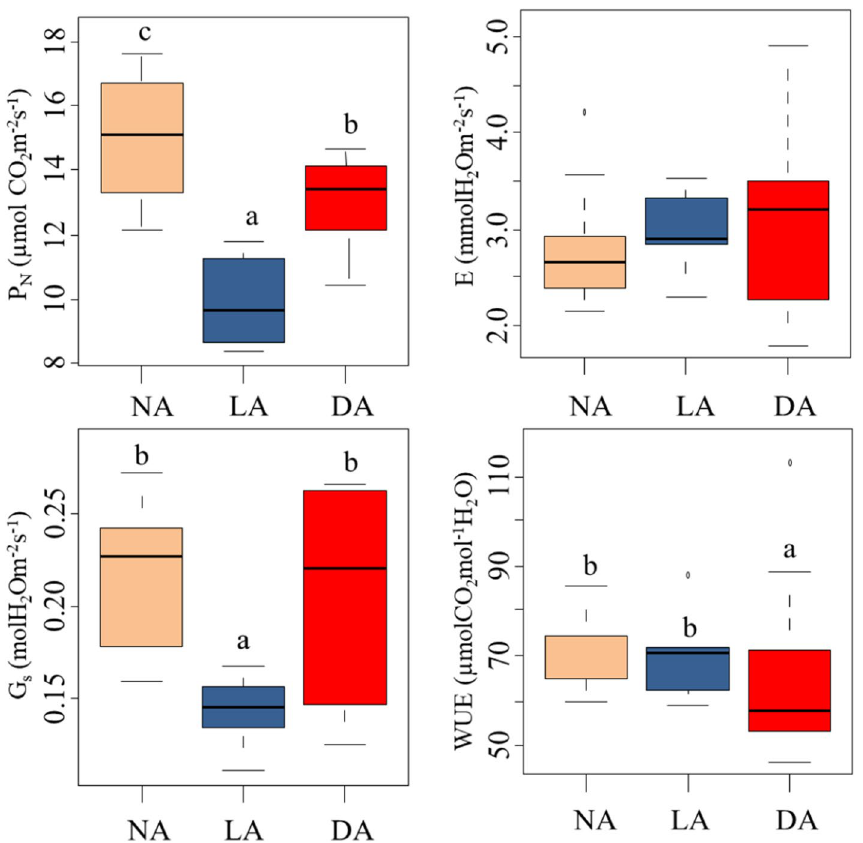
Figure 2. Variability in leaf gas exchange parameters of R. anthopogon during the three acclimation phases [i.e., Non-acclimation (31 August, 2018), Cold acclimation (18 September, 2018) and De-acclimation (15 June, 2018)]. Different alphabets (a, b, c) represent statistically significant values ( p < 0.05) as determined by Tukey’s post-hoc test. P N = Photosynthetic rate, E = Transpiration rate, G S = Stomatal conductance and WUE = Water use efficiency.